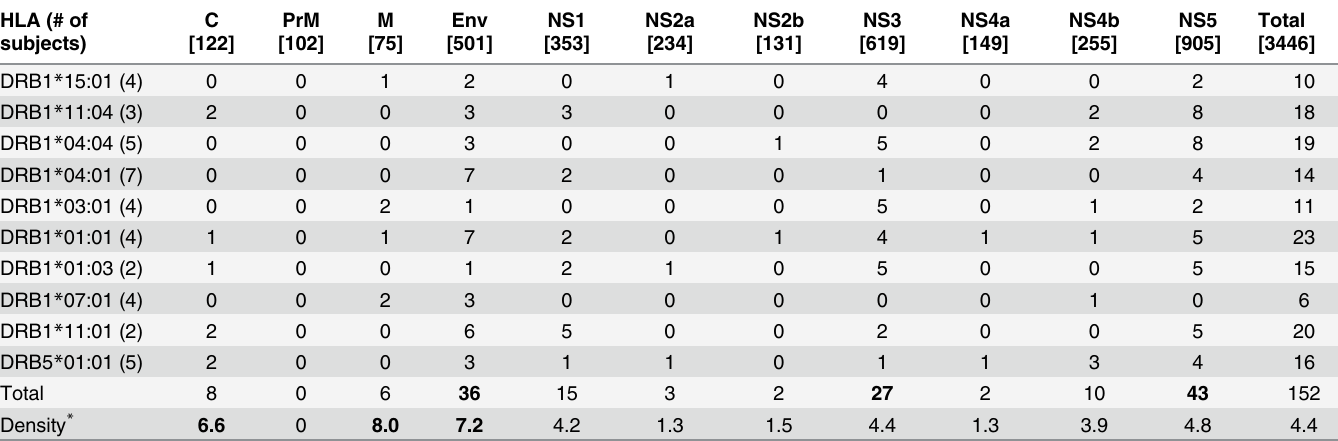
Table 2. Density of WNV protein epitopes among ten HLA-DR